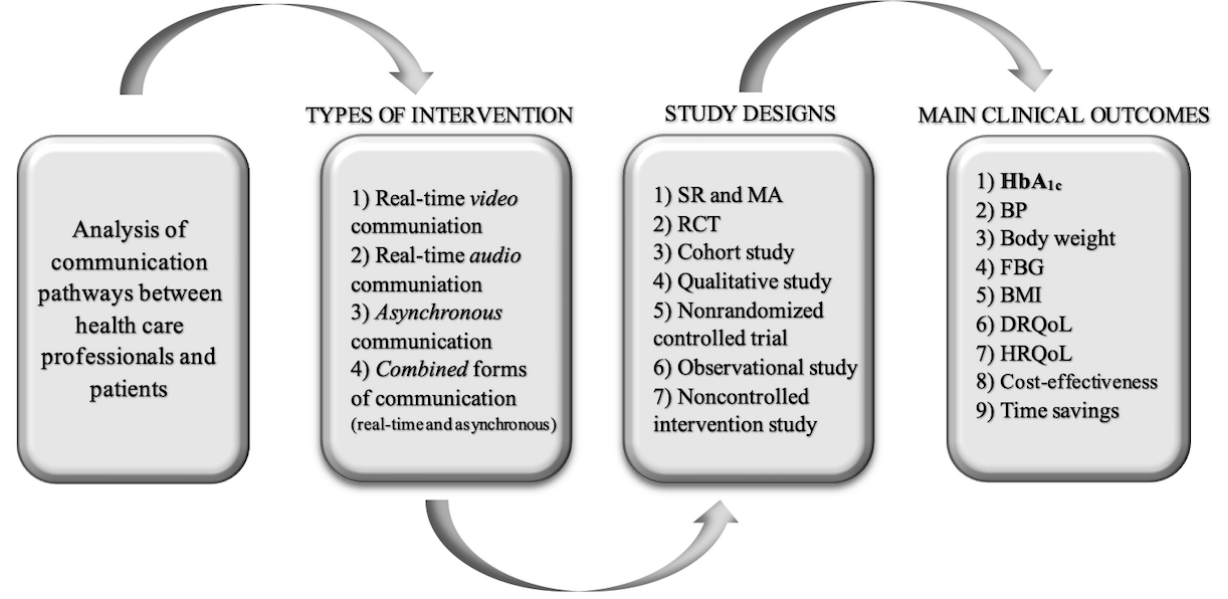
Figure 1. Study classification procedure. BP: blood pressure; DRQoL: disease-related quality of life; FBG: fasting blood glucose; HbA 1c : glycated hemoglobin A1c; HRQoL: health-related quality of life; MA: meta-analysis; RCT: randomized controlled trial; SR: systematic